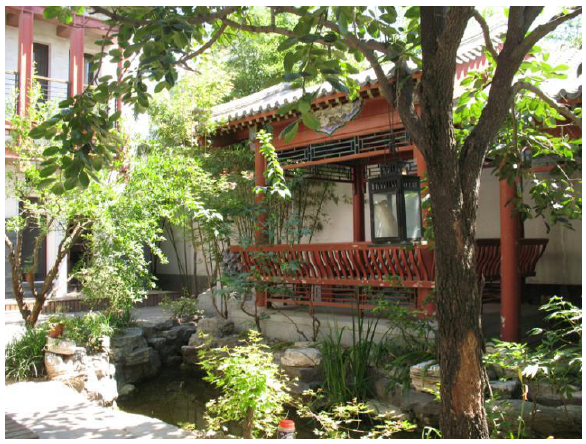
Figure 14. Courtyard/garden of a Beijing Guantang villa with classical Suzhou-style garden elements of fish pond and pavilion. Photo: Donia Zhang